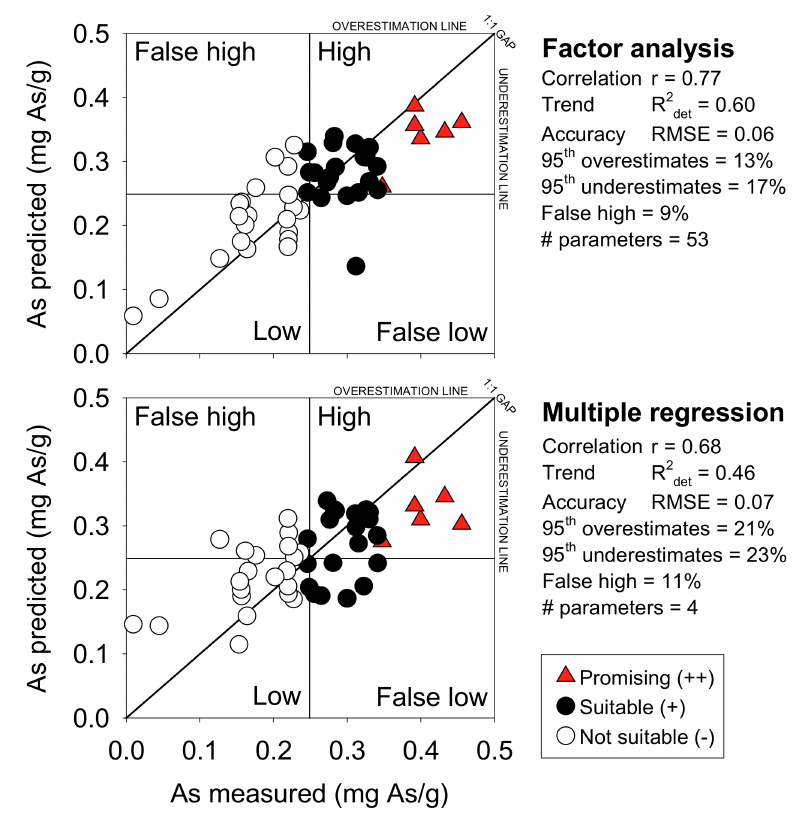
Figure 5. Multiparameter linear regression results based on ( a ) factor analysis performed on 53 parameters and ( b ) multiple linear stepwise forward regression, based on four selected parameters (As, La, Pb, and P). Goodness of fit are expressed through R 2 and root mean square error (RMSE). Percentiles lines (95%) of prediction are plotted (dashed lines). Symbols indicate samples not suitable (-), suitable ( + ), and promising ( ++ ) for As